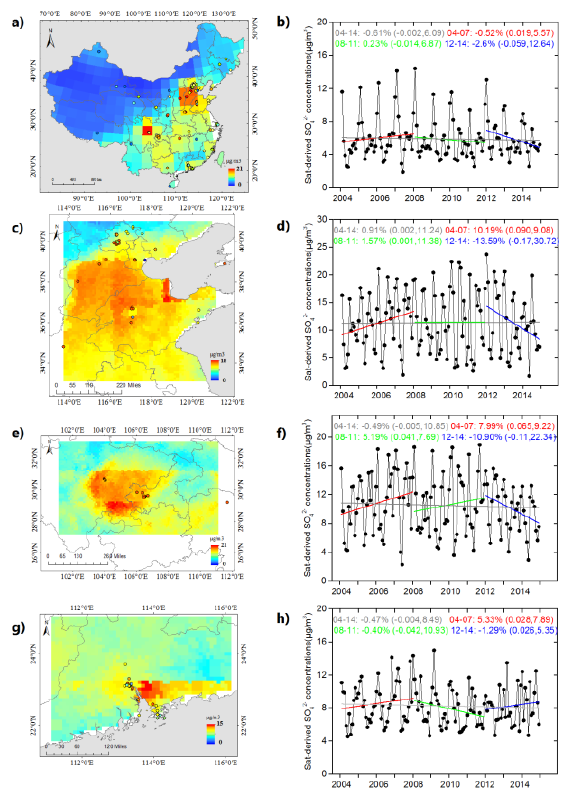
Figure 4. Spatial distribution of annual average satellite-derived SO 42− concentrations at a resolution of 2° × 2.5°. ( a ) Overlaid with ground measurements. ( b ) Time series of monthly satellite- derived SO 42− concentrations at the same resolution over China during the period 2004–2014. ( c , d ) Similar results to those presented in ( a , b ) but in the NCP at 0.1° × 0.1°. ( e , f ) Same as ( c , d ) but in the SCB. ( g , h ) Same as ( c , d ) but in the PRD. The spatial distributions and time series of ammonium concentrations are shown in Figure 5. On the national scale, the satellite-derived ammonium concentrations exhibited an overall negative trend of 0.21% per year during the study period; a positive trend of 0.41% occurred in 2008–2011, whereas a decreasing trend of 0.43% per year was observed in 2004–2007, followed by a negative annual trend in 2012–2014.